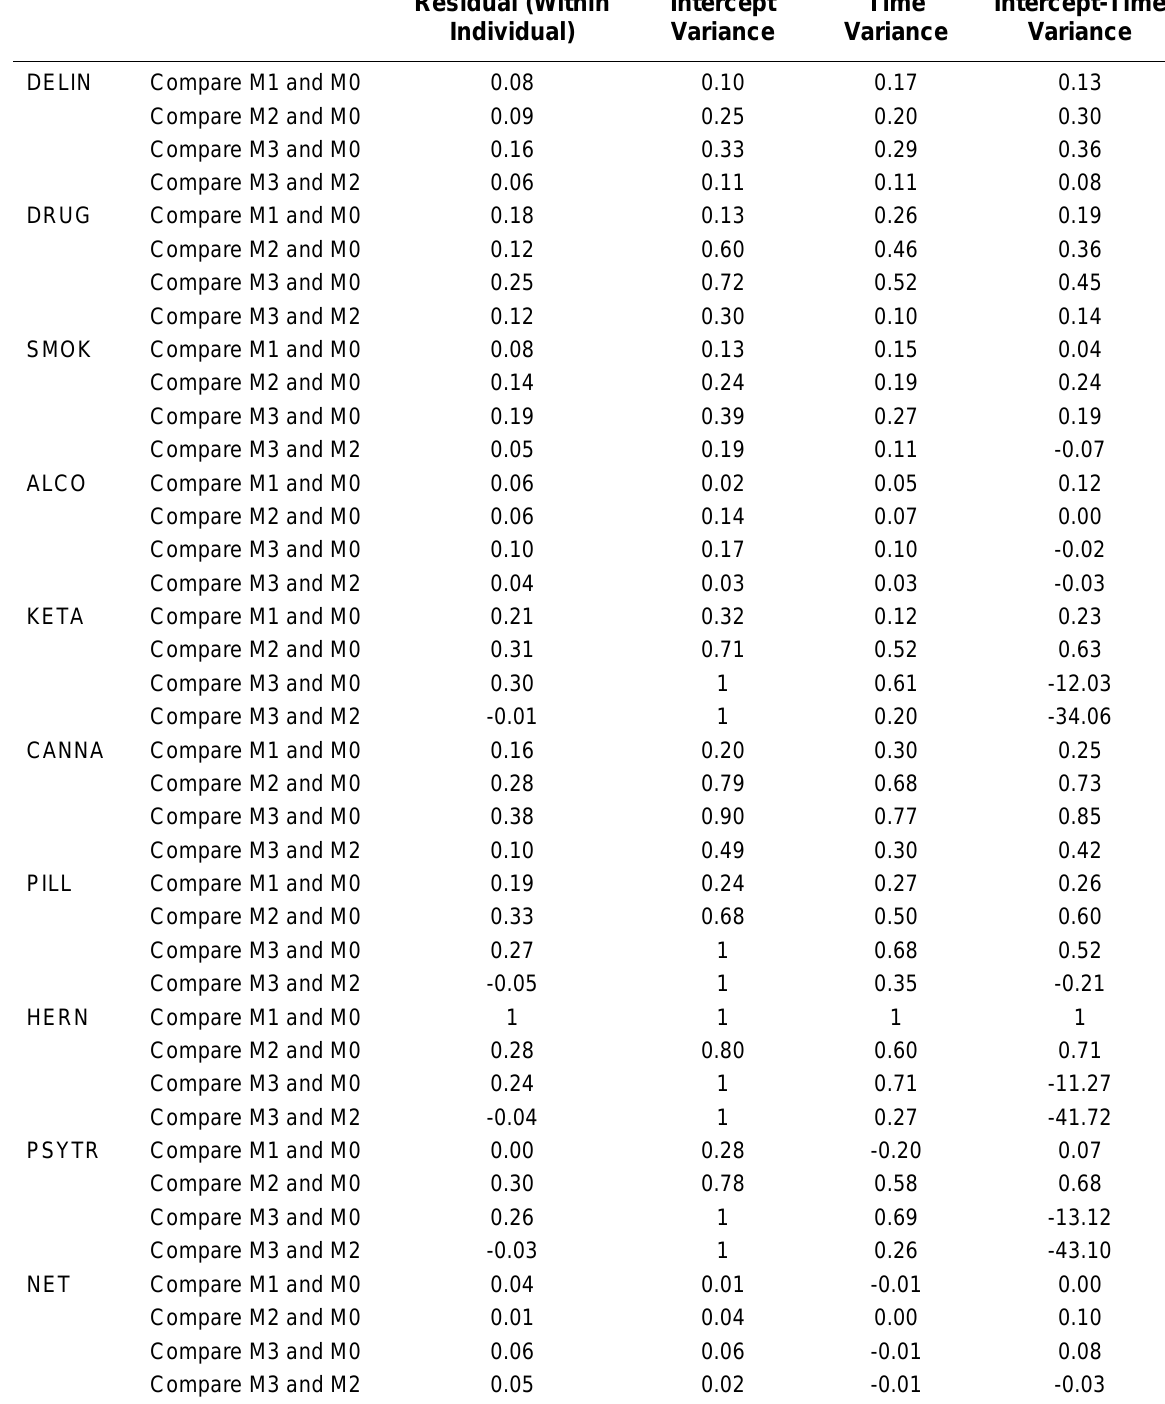
Pseudo-R 2 for IGC with Subjects who Joined the Tier 1 Program and Perceived the Program